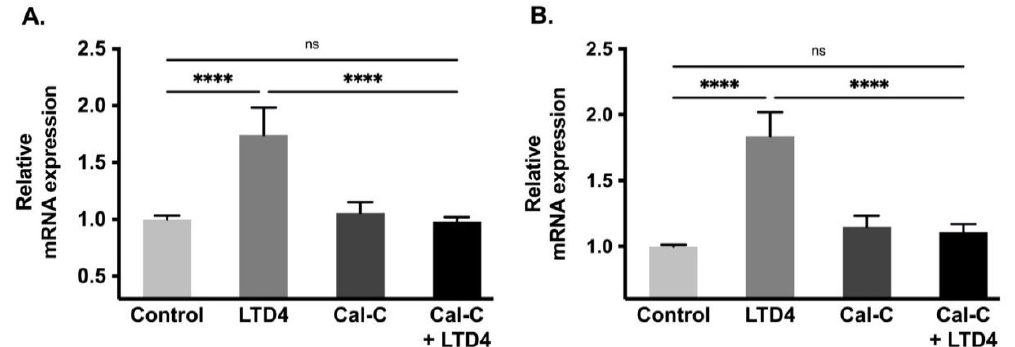
Figure 6. Quantification of Na-K-ATPase α 1 and Na-K-ATPase β 1 mRNA through quantitative real-time PCR (qRT-PCR) when treated with LTD4 and calphostin-C (PKC inhibitor) for 24 h. Values are relative to control and normalized to β -actin. ( A ) Na-K-ATPase α 1. ( B ) Na-K-ATPase β 1. Values are represented as mean ± SEM ( n = 6, Tukey’s multiple comparisons test). **** p < 0.0001; ns., not significant.